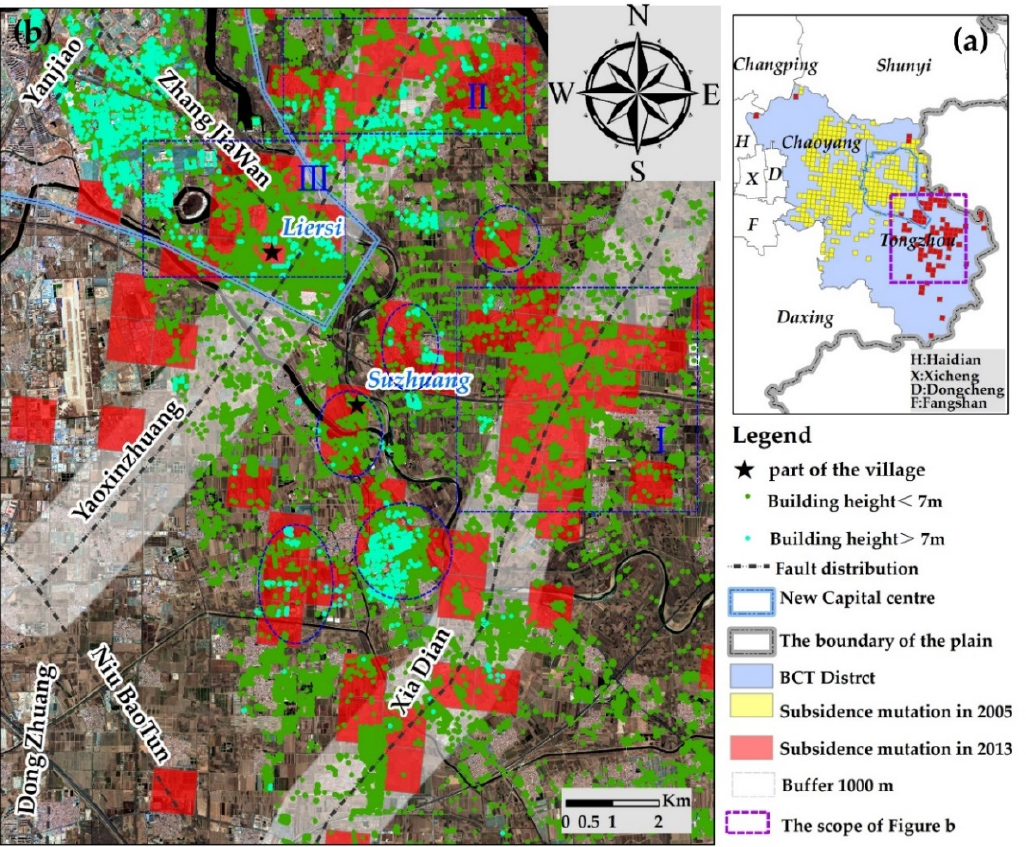
Figure 12. Response relationship between high-rise buildings and subsidence mutation at the local scale. ( a ) shows the location of ( b ). ( b ) shows the relationship between high-rise buildings and subsidence mutation. The red square represents the subsidence mutation occurred in 2013 in Tongzhou of the Beijing Plain, and the blue point represents the individual building greater than 7m.